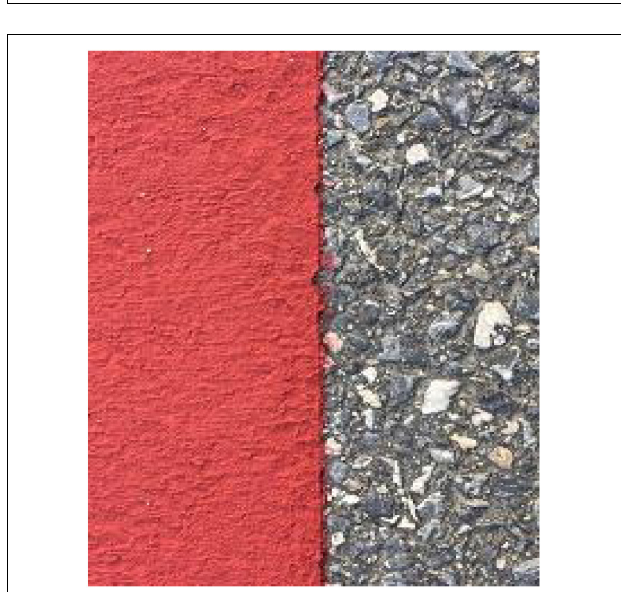
FIGURE 5 | CEASM after molding.